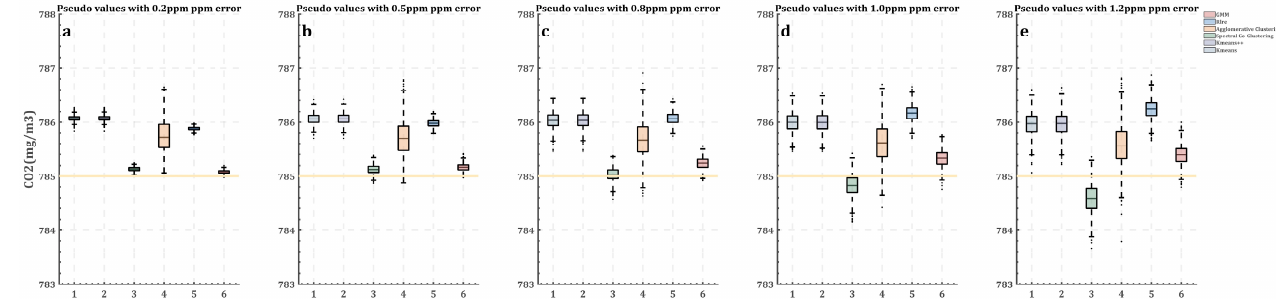
Figure 10. Background concentration estimates in pseudo measurements with two peaks.